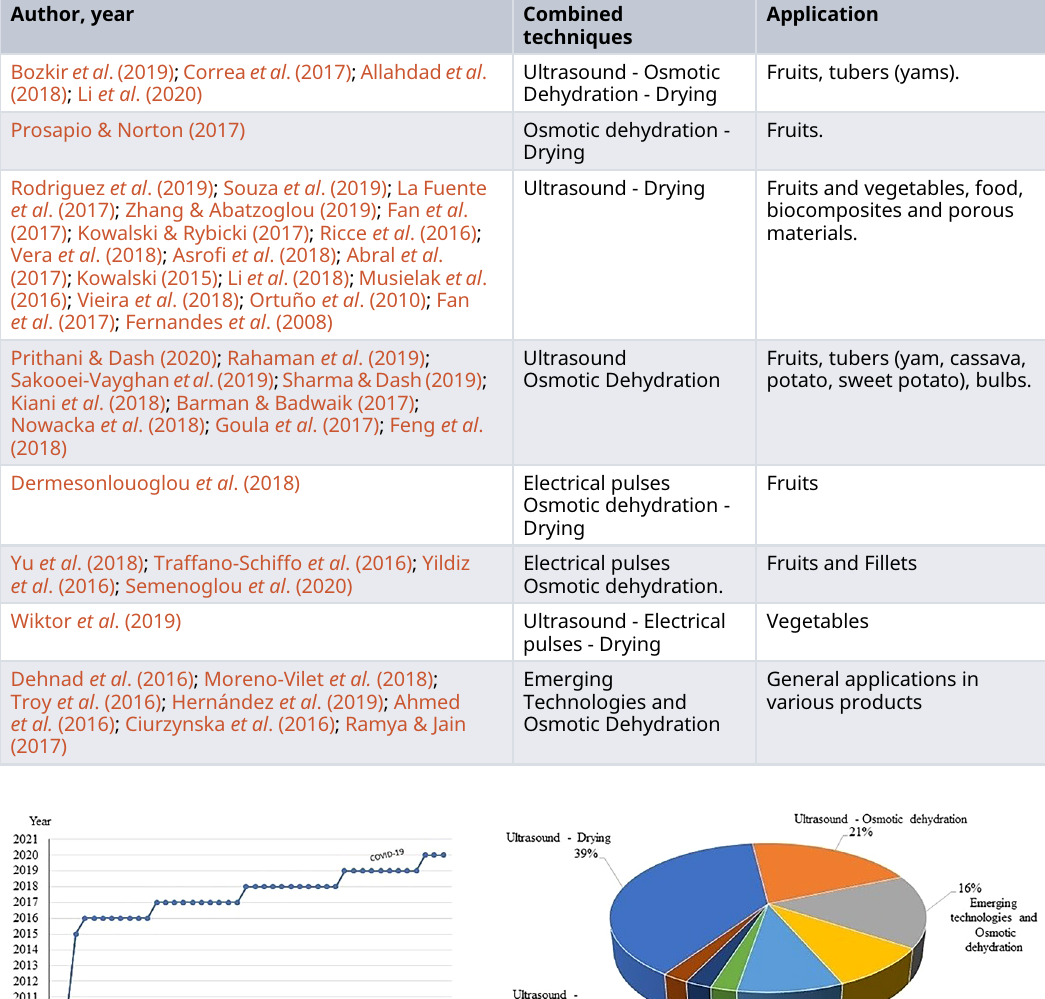
Table 3. Technological applications of the combined techniques of ultrasound, electrical pulses, dehydration and drying of different products.